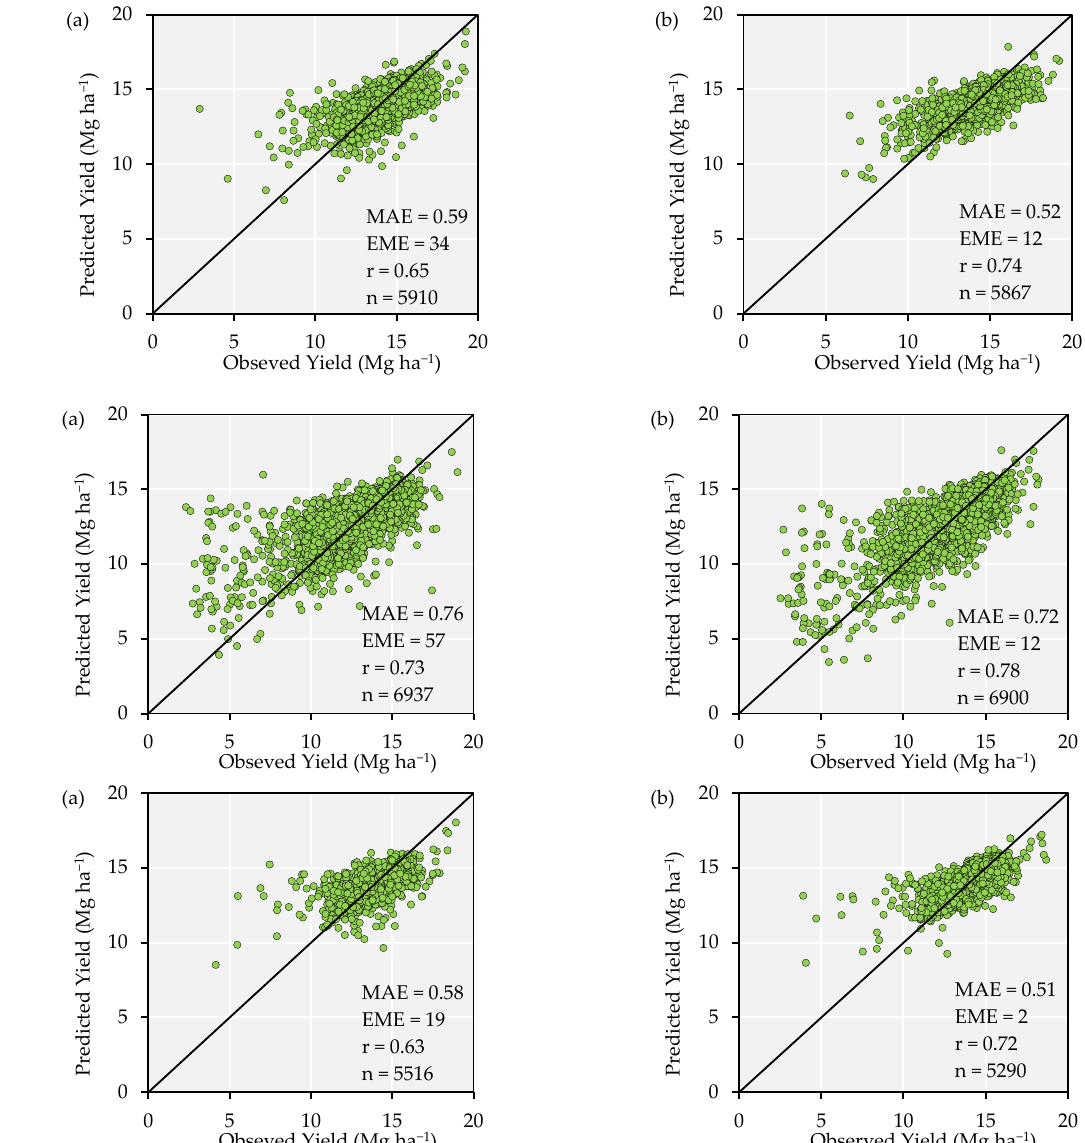
Figure 13. Performance analysis of test dataset with the features spectral bands + TPI + TWI in two approaches of model calibration, ( a ) whole-field and ( b ) site-specific models, in the scenario of the season 2018. Observation: MAE (mean absolute error) is expressed in Mg ha −1 , EME (estimative mean error) in Kg ha −1 , and r is the correlation coefficient.